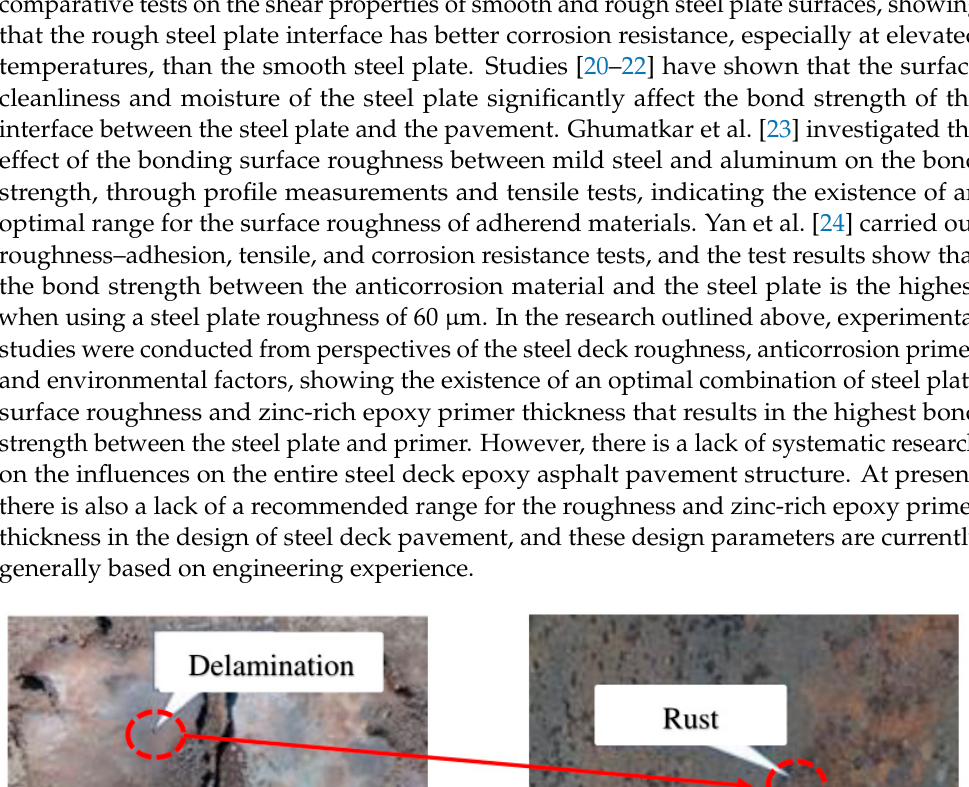
Figure 1. Steel deck pavement composite structure.